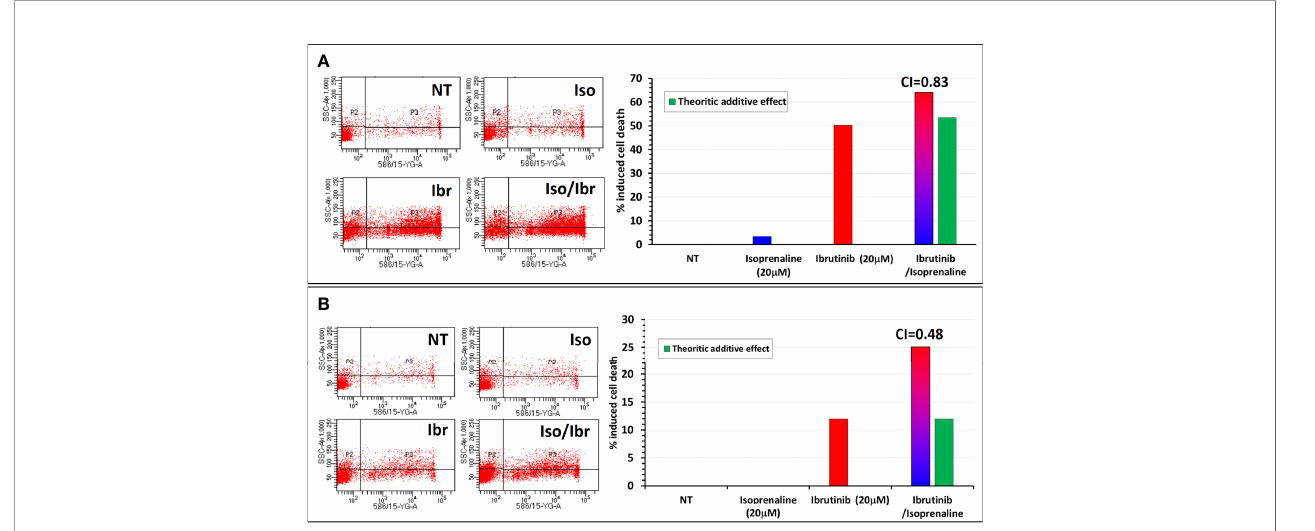
FIGURE 8 | Synergistic effect between Isoprenaline and the Bruton ’ s tyrosine kinase inhibitor (Ibrutinib). (A) Combinatorial treatment of CLL primary cancer cells with Isoprenaline (20 m M) and Ibrutinib (20 m M) shows that Isoprenaline sensitizes CLL primary cancer cells to the cytotoxic effect of Ibrutinib. (B) This synergistic effect between Isoprenaline and Ibrutinib was more pronounced (CI=0.48) in CPCs showing higher resistance to Ibrutinib than in more sensitive CPCs